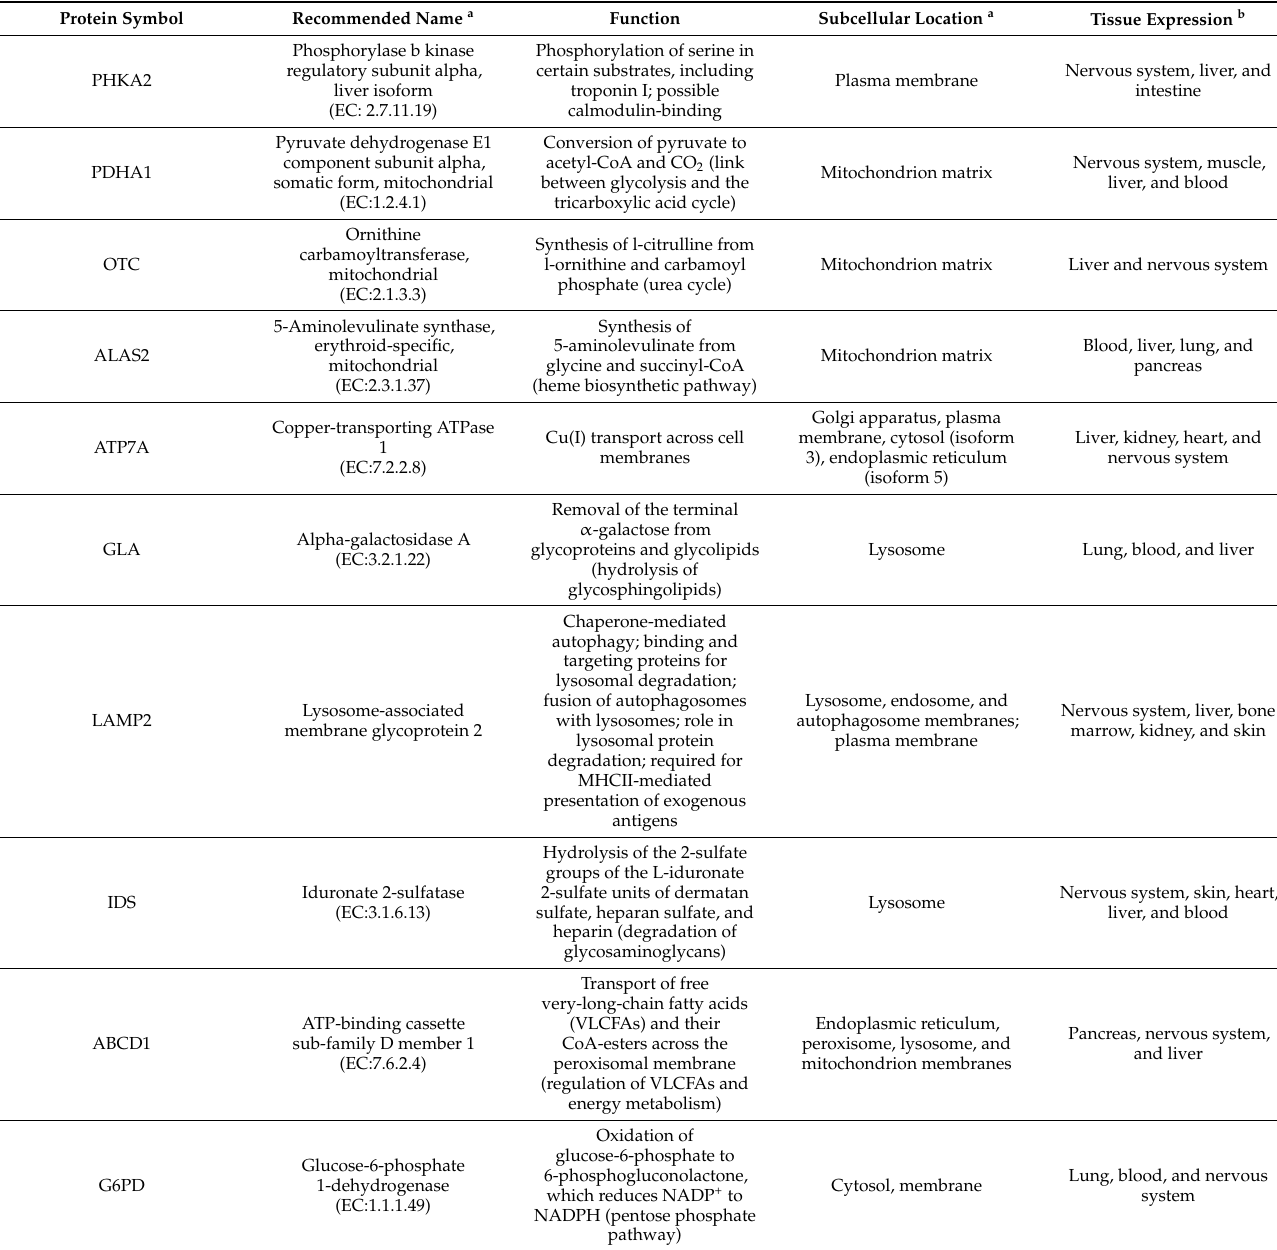
Table 4. Characteristics of proteins affected in the disorders described in this